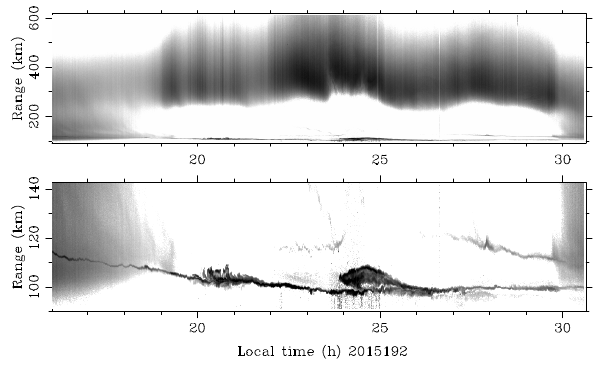
Figure 1. Incoherent scatter observed by the line feed system at the Arecibo Radio Observatory on 11/12 July 2015. Grayscales rep- resent range-corrected power, which serves as a proxy for elec- tron number density. The top panel shows E - and F -region data, whereas the bottom panel shows E -region data in more